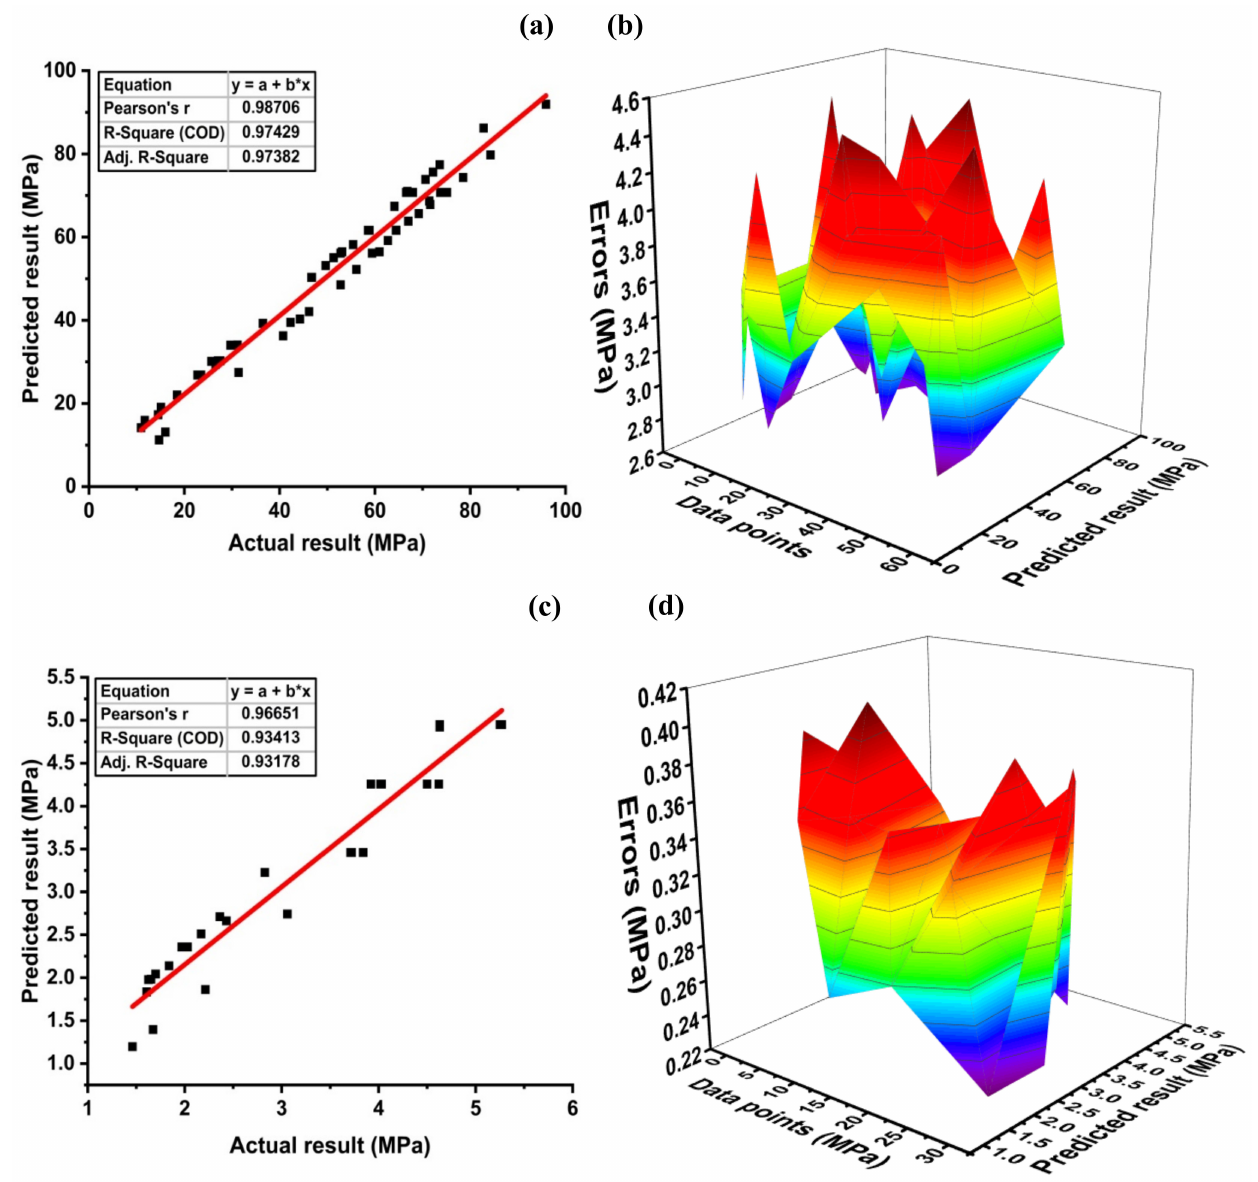
Figure 12. GEP model for ( a ) compressive strength and ( b ) its error distribution; ( c ) split tensile strength and ( d ) its error